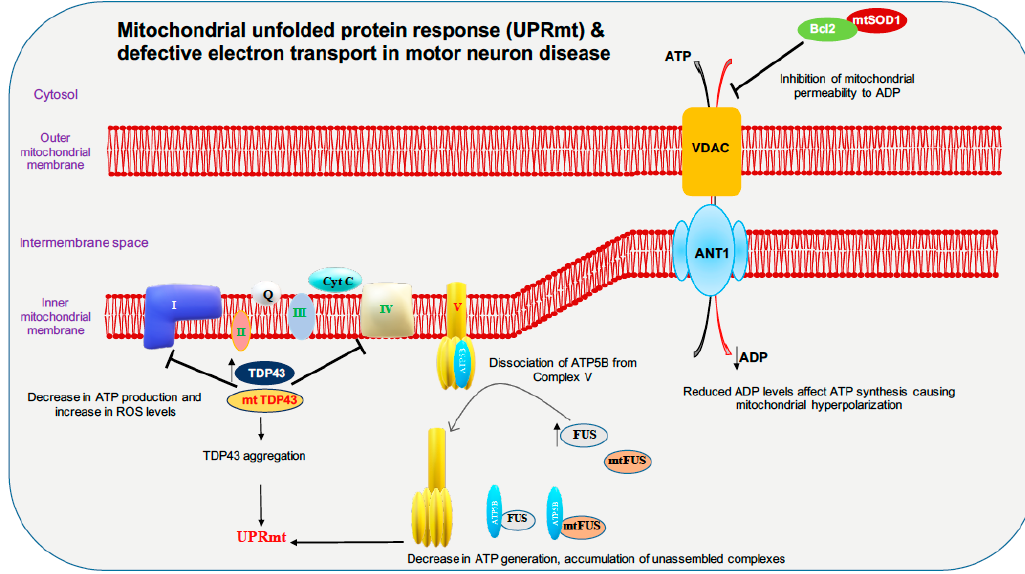
Figure 2. Motor neuron disease factors are linked to mitochondrial unfolded protein response (UPRmt) and defective electron transport chain. For ATP generation, proper functioning of electron